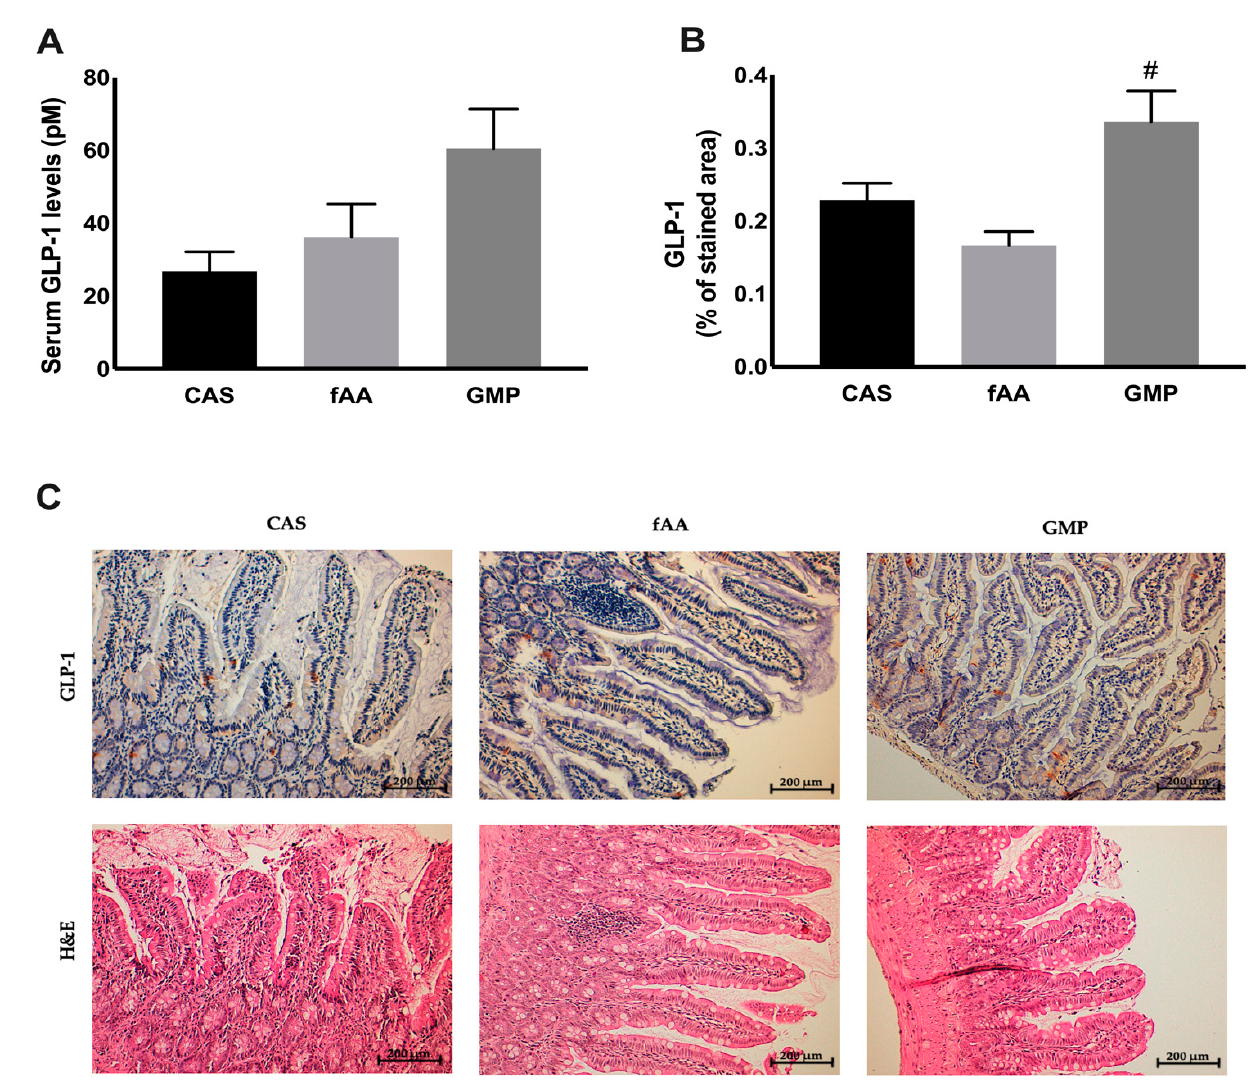
Figure 3. Serum GLP-1 levels ( A ) in the 3 study groups. Data are presented as mean ± SEM ( n = 4–7/group). One-way ANOVA with Bonferroni’s post-hoc test was performed. GLP-1 (% of stained area) ( B ) in the 3 study groups. Data are presented as mean ± SEM ( n = 34–39 images/group). One-way ANOVA with Bonferroni’s post-hoc test was performed. # p < 0.05 vs. fAA. Ileum GLP-1 IHC and H&E images ( C ). CAS: casein; fAA: free amino acids; GLP-1: glucagon-like peptide-1; GMP: glycomacropeptide; H&E: hematoxylin and eosin; IHC: